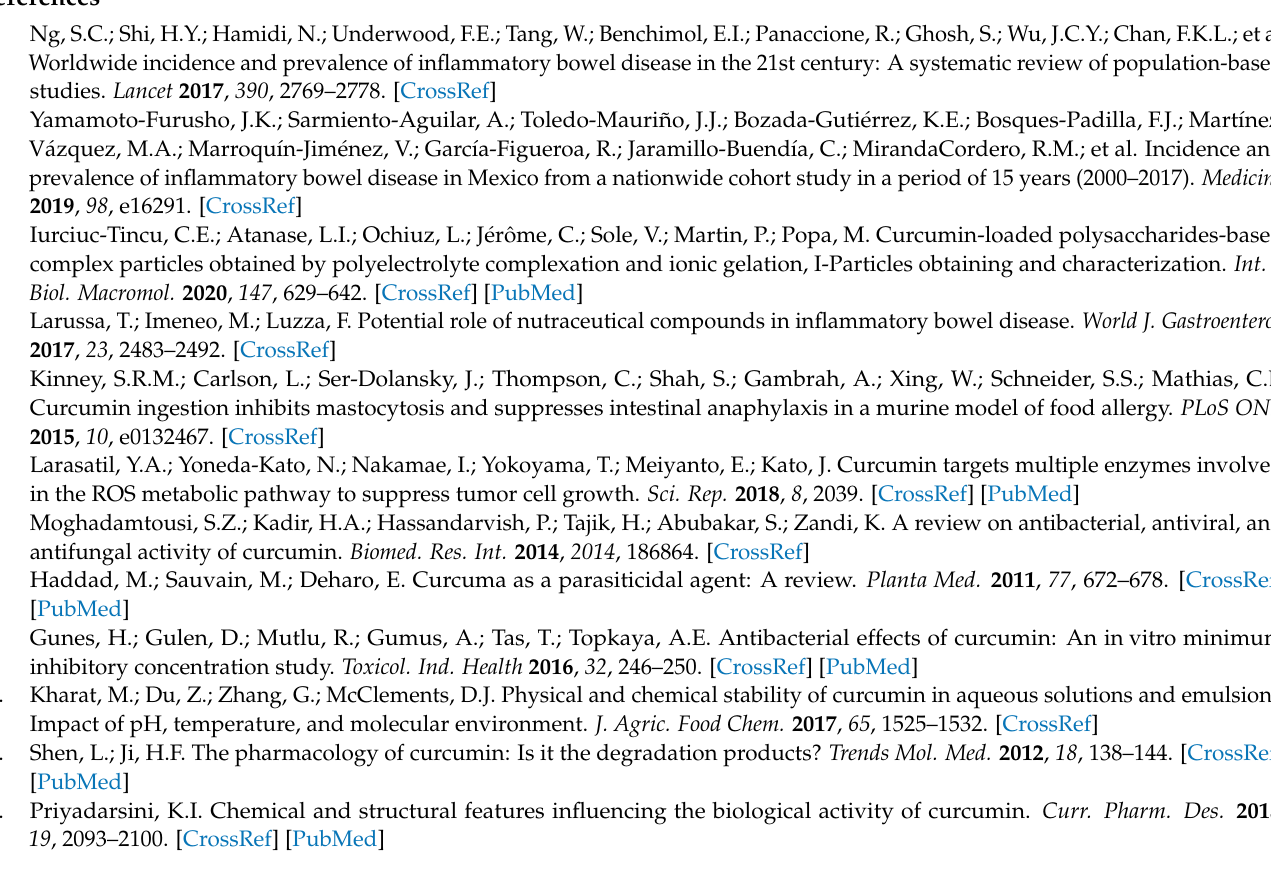
Table S1: Variation of non-degraded curcumin (%) in time, in buffer solutions with different pH values, for the analyzed samples, Table S2: The TPC or TFC determined from free curcumin (FC) and curcumin extracted from P2C, P4C, and P5C samples irradiated or not irradiated with UVA. The results are expressed as mean values ±